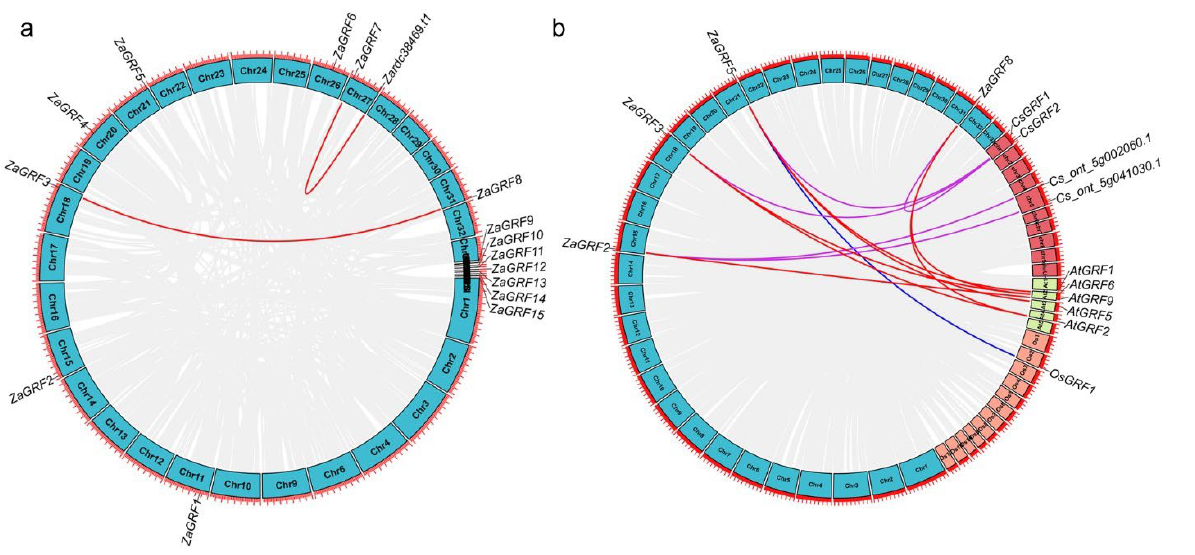
Figure 6. Colinear analysis. ( a ) chromosome distribution and collinearity analysis of ZaGRF genes and ( b ) colinear analysis of GRF genes among Zanthoxylum armatum , Citrus sinensis , Arabidopsis thaliana and Oryza sativa .